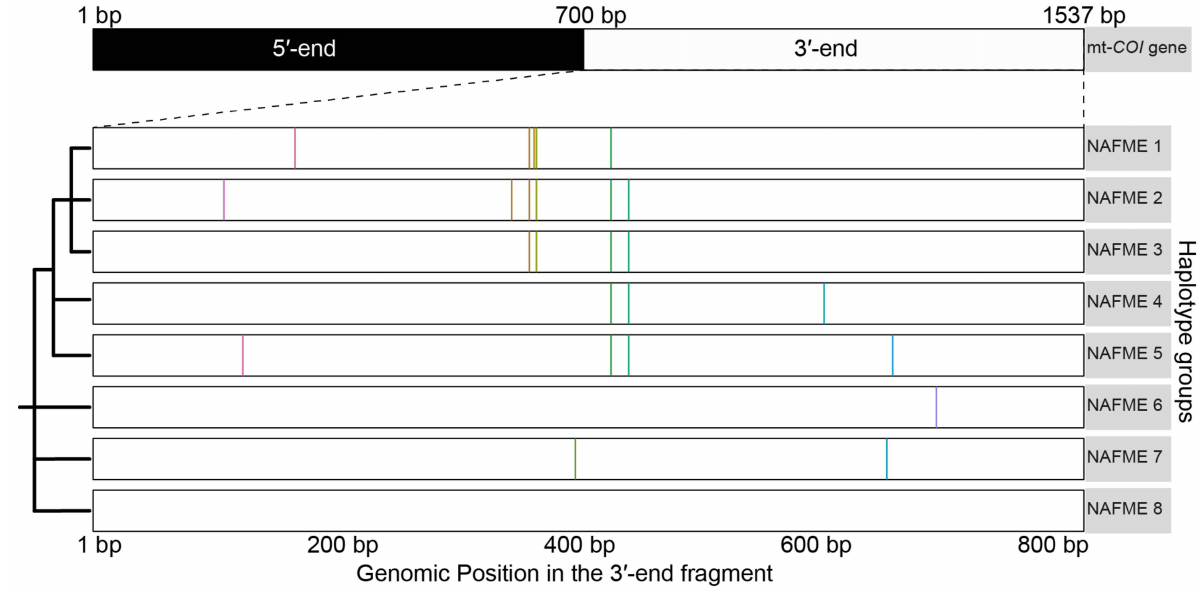
Figure 1. Schematic representation of the ‘signature SNPs’, or those that differentiated the eight unique haplotypes groups of the Bemisia tabaci B mitotype. Color bars indicate the locations of signature SNPs identified in the 3 (cid:48) -end of the COI